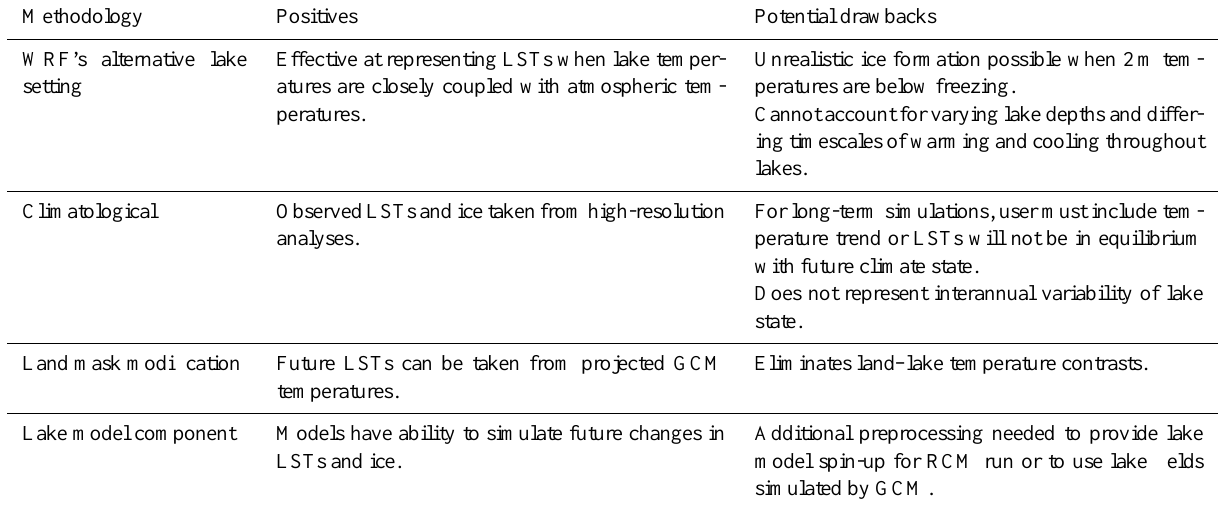
Table 2. A summary of the pros and cons of each method of treating lake surface temperatures and ice coverage described in the text. All Fig.